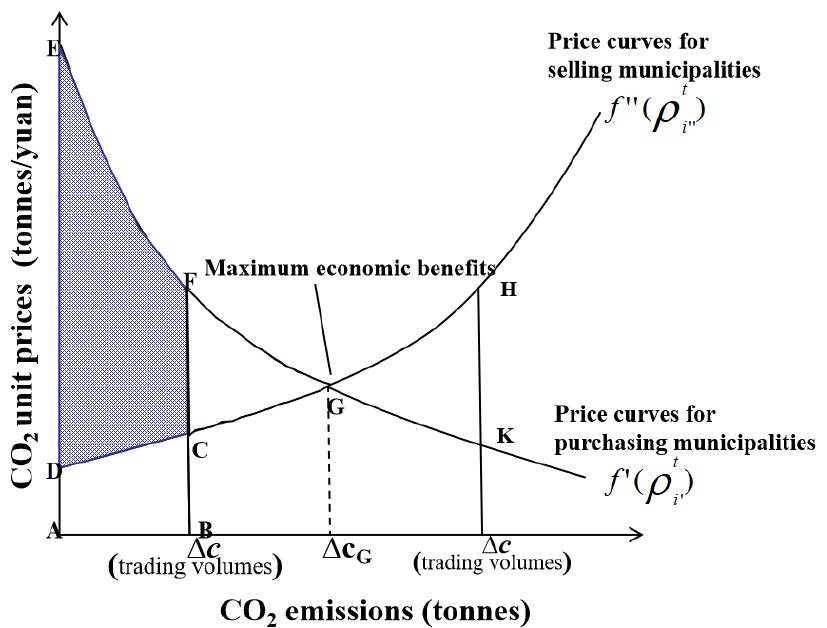
Figure 2. Figure 2. Diagram of the economic benefits based on CO 2 trading. Note: When ∆ c < ∆ c G , the CO 2 emissions efficiency of all the purchasing municipalities is higher than that of the selling ones, and CO 2 emission rights for ∆ c tons lead to positive economic benefits in CO 2 trading ( S DCEF ), which is also the overall economic benefit. when ∆ c > ∆ c G , the CO 2 emissions efficiency of some purchasing municipalities is lower than that of the selling ones, and ∆ c tons of CO 2 emission rights generate positive benefits ( S EDG ), while ( ∆ c − ∆ cG ) tons lead to negative economic benefits ( S HKG ), and the overall economic benefit is ( S EDG − S HKG